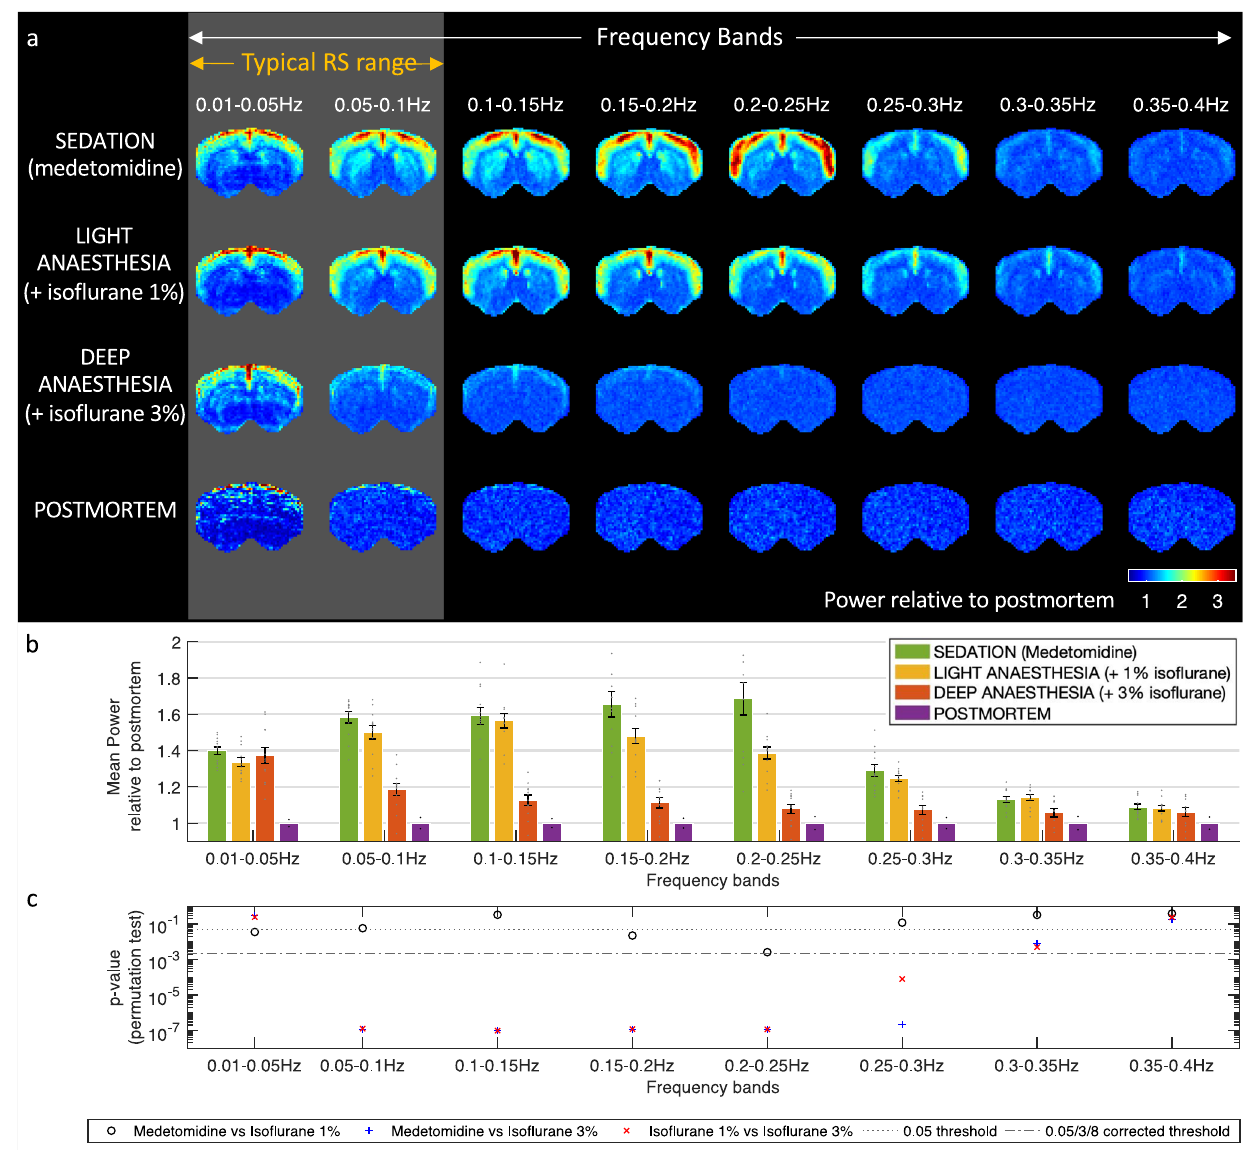
Fig. 2 | Spectral power of fMRI signals differs signi fi cantly between anesthesia conditions. a Spatial maps of spectral power in 8 non-overlapping frequency bands, averaged across the s =12 fMRI scans recorded under each anesthesia conditions and normalized by the mean power in s PM =2 postmortem scans. fMRI recordings were recorded from n =6 genetically similar female rats, each scanned twice in 3 anesthesia conditions (with iso fl urane at 0%, 1%, and 3%. b Power in 8 frequency bands averaged across all brain voxels relative to the mean power in 2 postmortemscans.Dotscorrespondtothemeanpowerineachscananderrorbars